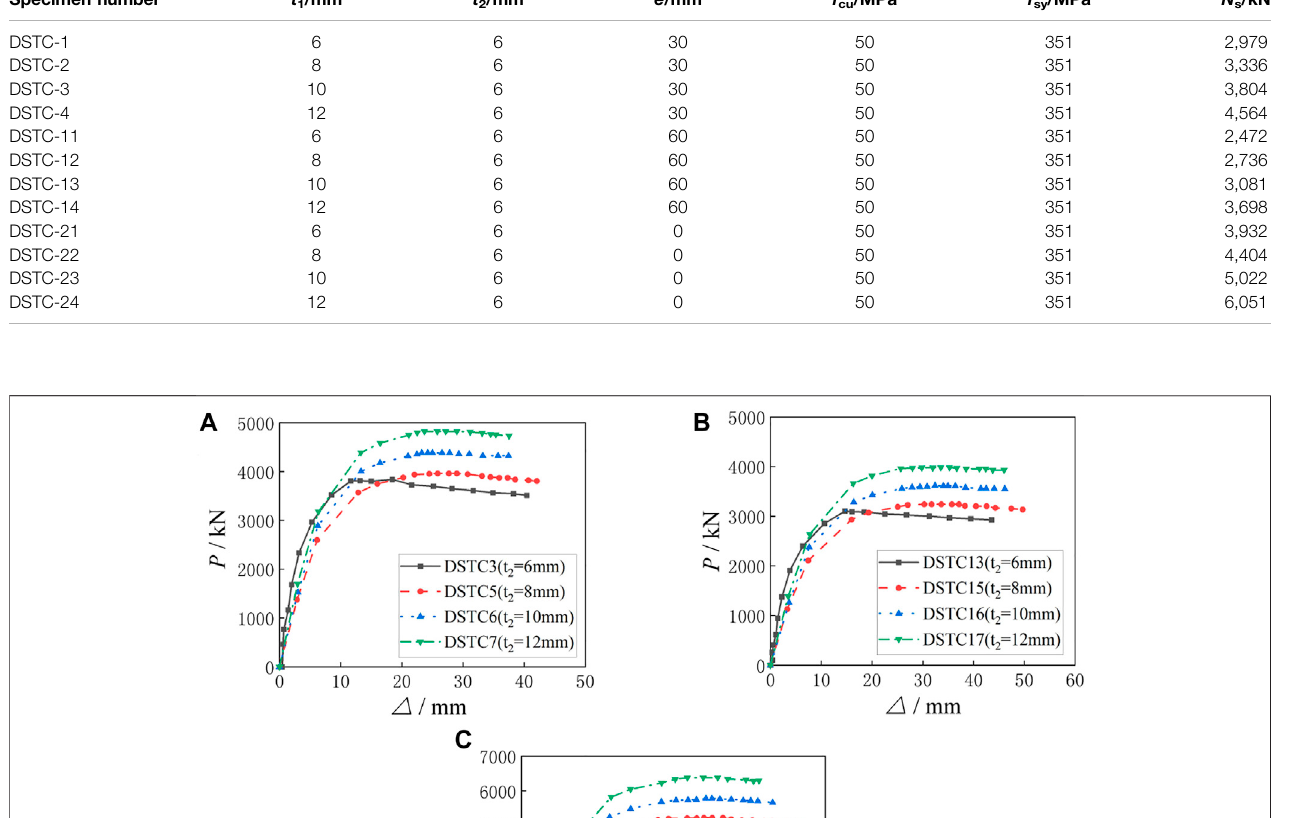
TABLE 6 | Ultimate eccentrical compression bearing capacity of specimens with different thicknesses of GFRP pipe. Specimen number